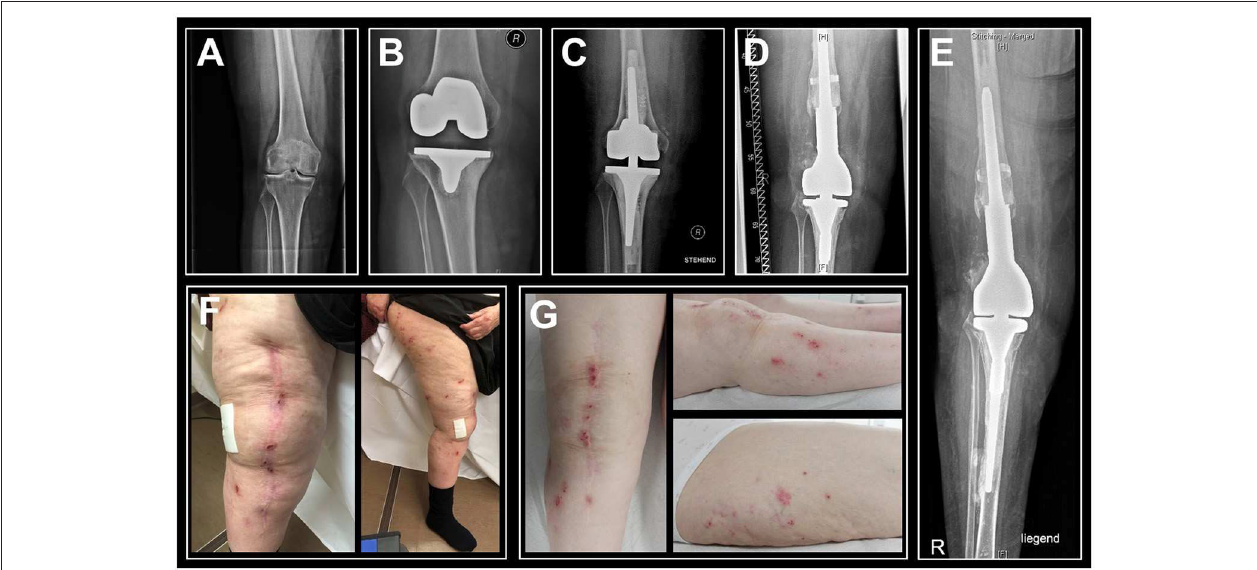
FIGURE 1 | Sequential anteroposterior radiographs of the patient’s right knee indicate progression of bone loss and photographs of the right leg show persisting eczema. (A) Radiography prior to primary knee replacement depicts joint degeneration secondary to rheumatoid arthritis, 2009/03. (B) Pre-revisional radiograph indicates peri-implant bone loss and loosening of the tibial component, 2012/03. (C) Post-revisional radiograph depicts intense intraoperative usage of cement and progressive bone loss, 2012/07. (D) Radiographic status at the time of hypersensitivity diagnostics, 03/2018. (E) Latest radiographic status (patient in supine position), 01/2019. (F) Eczema at the time of hypersensitivity diagnostics, 03/2018. (G) Follow-up examination in the aftermath of rituximab therapy indicated an unimproved cutaneous status,